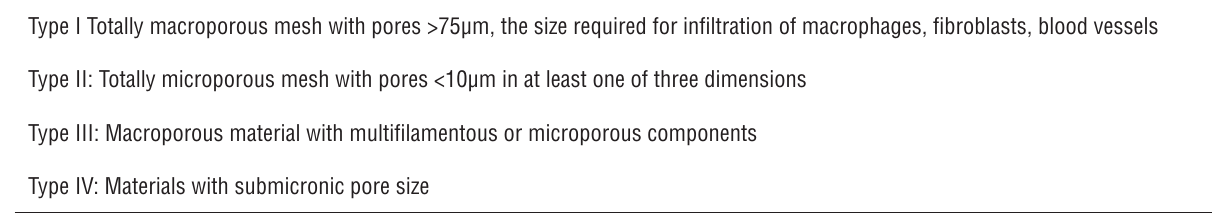
Table 1 - Amid’s Classification of Synthetic